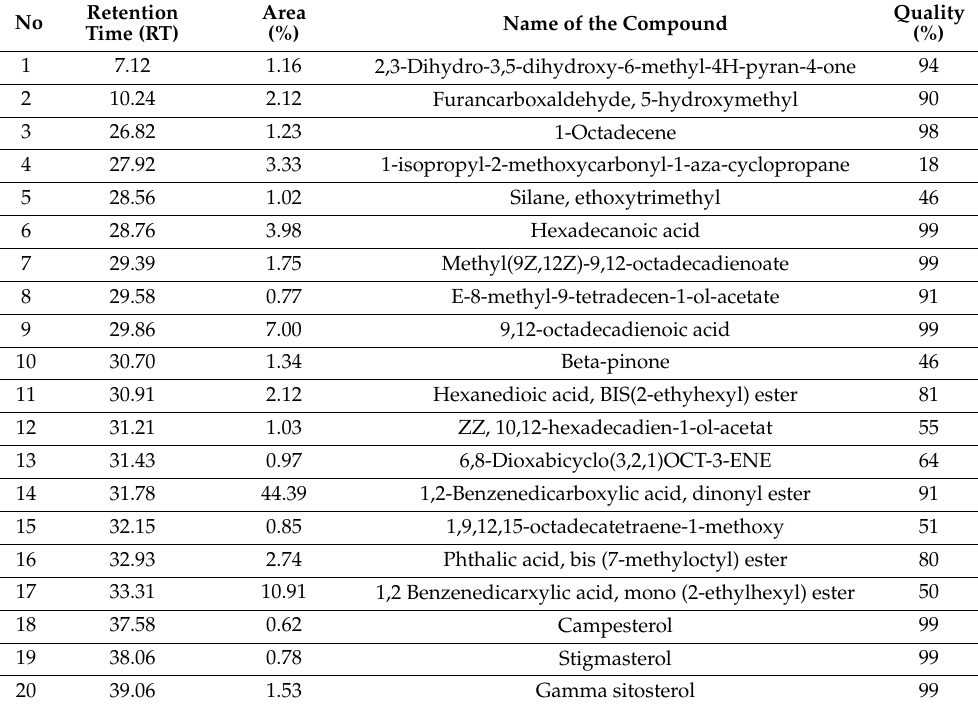
Table 2. The active compounds in ethanolic extract from Tacca tuber ( T.leontopetaloides ) by